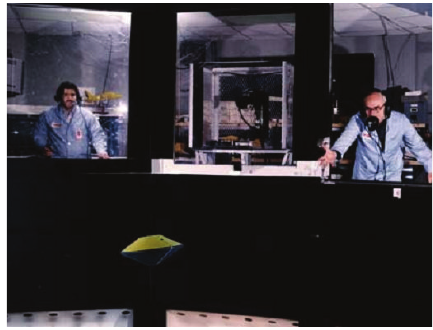
Figure 7: Return capsule model performing free fall motions in a VST